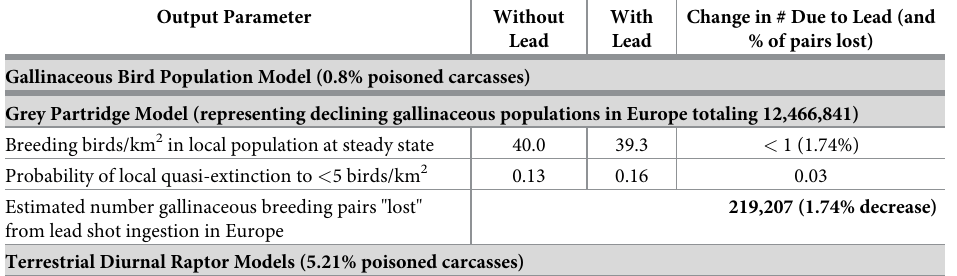
Table 4. Stochastic population modeling results for lead shot and bullet ingestion without effects on reproduction. Output Parameter Without With Change in # Due to Lead (and Lead Lead % of pairs lost) Gallinaceous Bird Population Model (0.8% poisoned carcasses) Grey Partridge Model (representing declining gallinaceous populations in Europe totaling 12,466,841) Breeding birds/km 2 in local population at steady state 40.0 39.3 < 1 (1.74%) Probability of local quasi-extinction to < 5 birds/km 2 0.13 0.16 0.03 Estimated number gallinaceous breeding pairs "lost" 219,207 (1.74% decrease) from lead shot ingestion in Europe Terrestrial Diurnal Raptor Models (5.21% poisoned carcasses) Common Buzzard Model (representing stable or decreasing raptor populations in Europe totaling 404 , 006 – 512,606) a Breeding pairs/10,000 km 2 in local population at steady 1,656 1,637 25 (1.1%) state Probability of local quasi-extinction to < 350 breeding 0.010 0.016 0.006 pairs/10,000 km 2 in 50 years Red Kite Model (representing stable and decreasing small-bodied raptor populations in Europe totaling 404 , 006 –512,606) a Breeding pairs/10,000 km 2 in local population at steady 1696 1629 67 (4.0%) state Probability of local quasi-extinction to < 350 breeding 0.00 0.00 0.00 pairs/10,000 km 2 in 50 years Red Kite Model (representing increasing small-bodied raptor populations in Europe totaling 53,868– 258 , 564 ) Breeding pairs/10,000 km 2 in local population when 1,331 1,222 109 (8.1%) reaches steady state Probability of local quasi-extinction to < 150 breeding 0.0017 0.0056 0.0039 pairs/10,000 km 2 in 50 years Maximum population growth rate 1.065 1.054 0.011 Bearded Vulture Model (representing stable and decreasing large-bodied raptor populations in Europe totaling 39,563) Breeding pairs/60,000 km 2 in local population at final 194 189 5 (2.7%) steady state Probability of local quasi-extinction to < 900 birds/ 0.012 0.031 0.019 60,000 km 2 in 50 years Bearded Vulture Model (representing increasing large-bodied raptor populations in Europe totaling 1,988) Breeding pairs/60,000 km 2 in increasing local population 189 184 5 (2.6%) (average of first 50 years) Probability of local quasi-extinction to < 900 birds/ 0.008 0.031 0.021 60,000 km 2 in 50 years Maximum population growth rate 1.076 1.077 0.001 Raptor Models Combined Estimated raptor breeding pairs/year lost from lead shot 32,655– 59 , 161 (2.9–5.3% decrease) and bullet ingestion in Europe